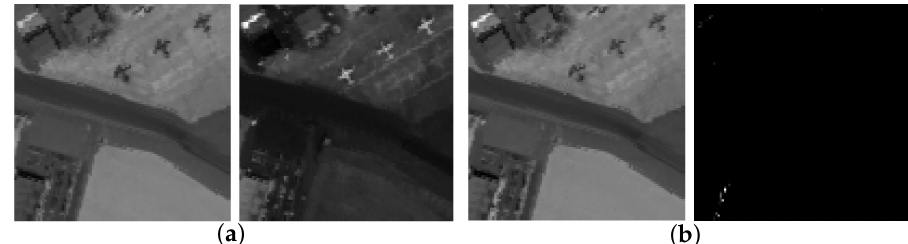
Figure 4. Low-rank part and sparse part with different settings of the tradeoff parameter λ . ( a ) Results when λ is set properly. ( b ) Results when λ is set